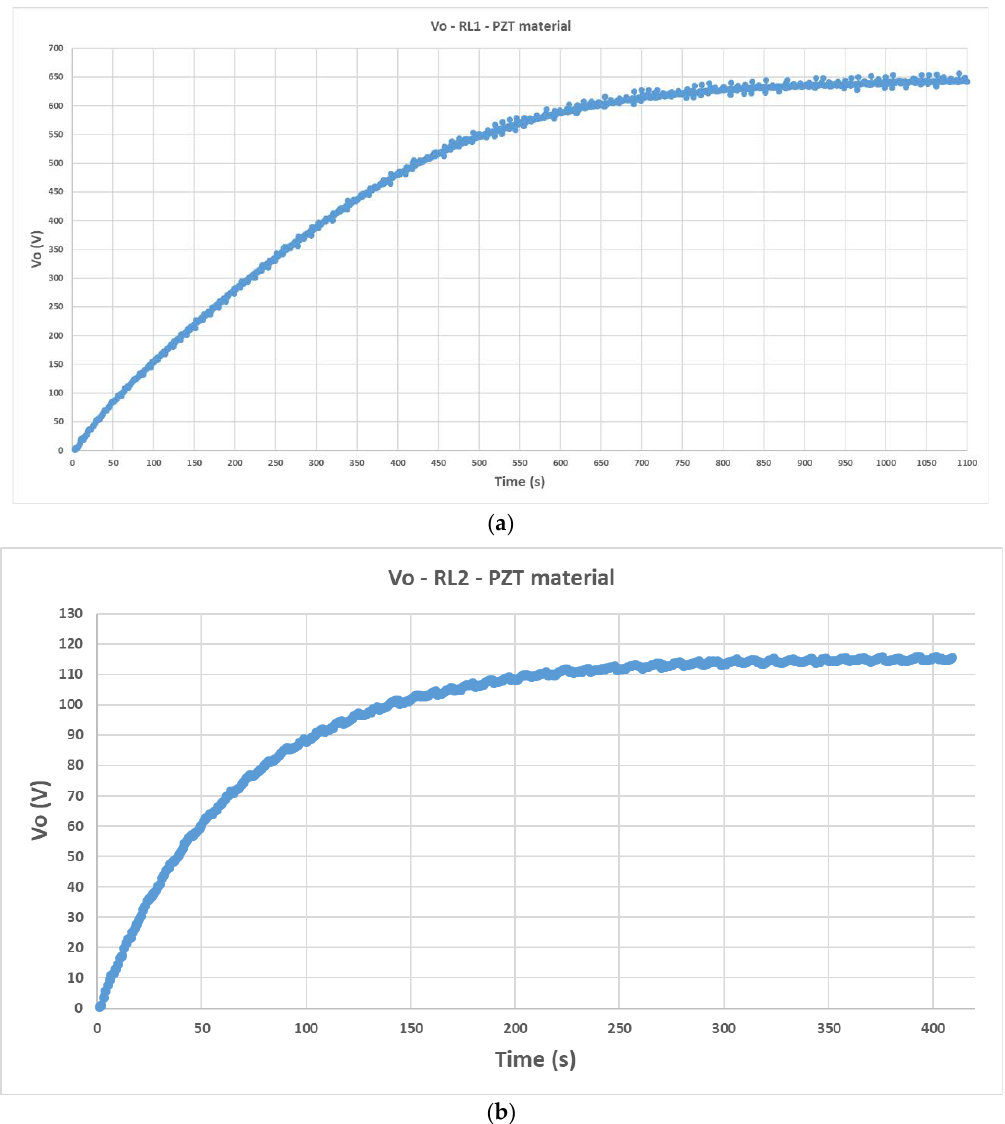
Table 3. Parameters of the piezoelectric energy harvesting application system.